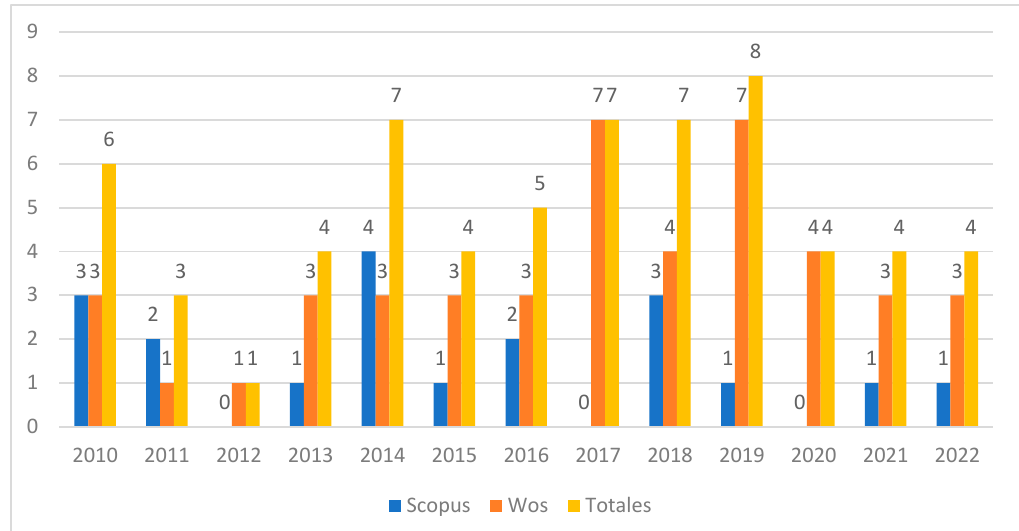
Figure 2. Articles published in the last 10 years in Scopus and WOS on learning mathematics through ICT resources in primary education. Source: own production.